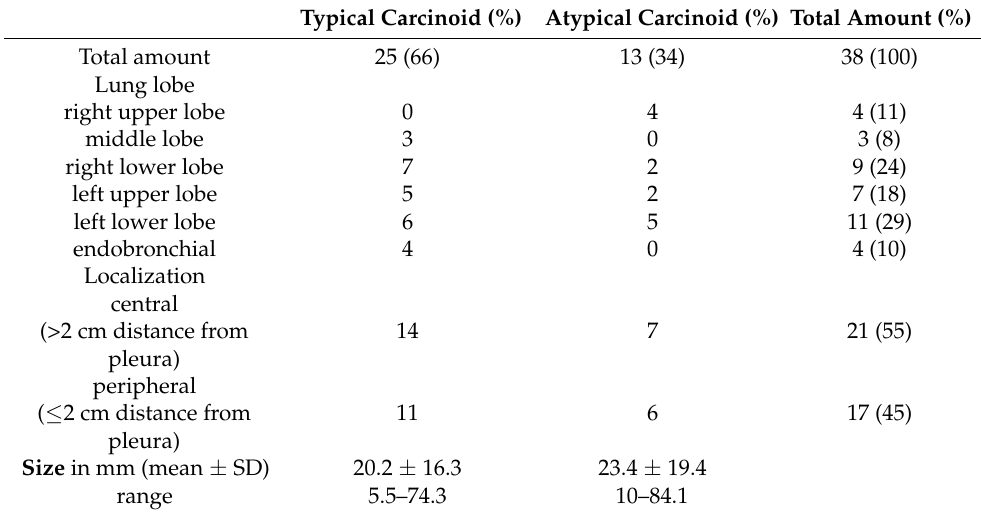
Table 1. Localization and size of the pulmonary neuroendocrine